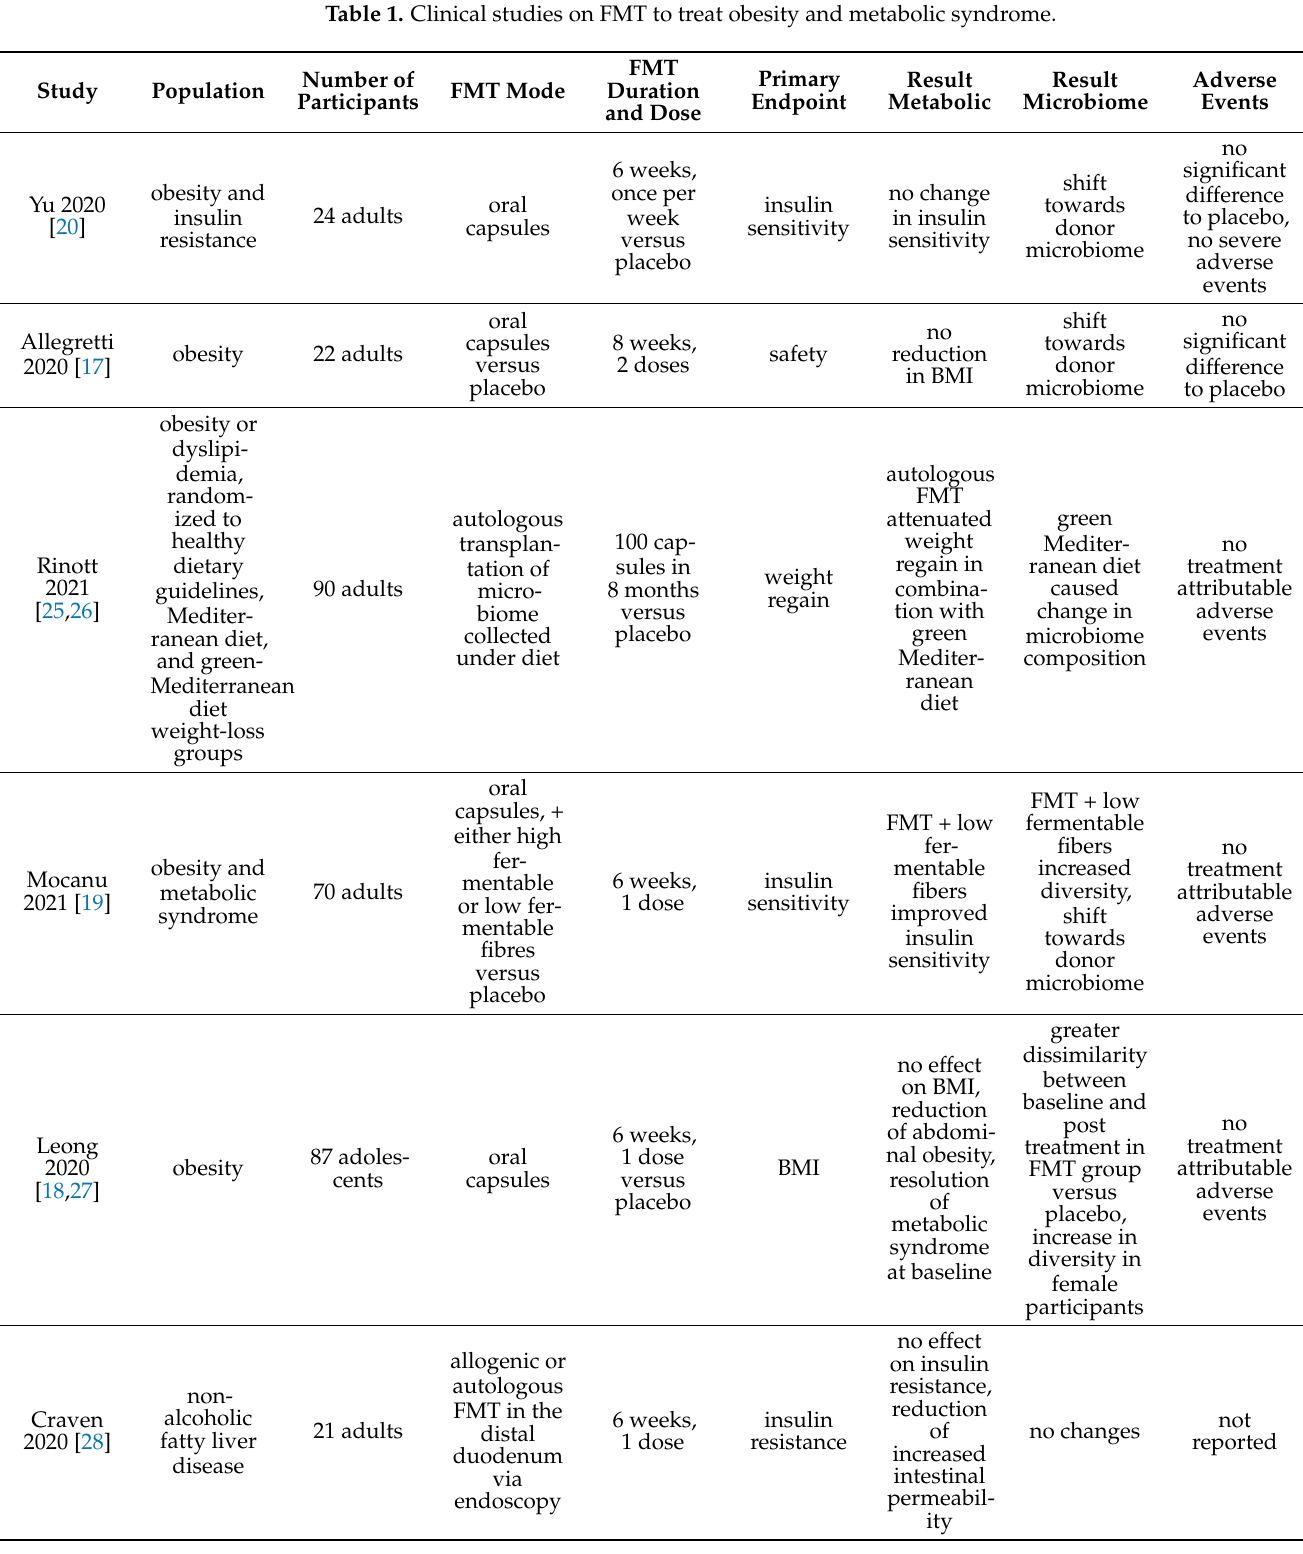
Table 1. Clinical studies on FMT to treat obesity and metabolic